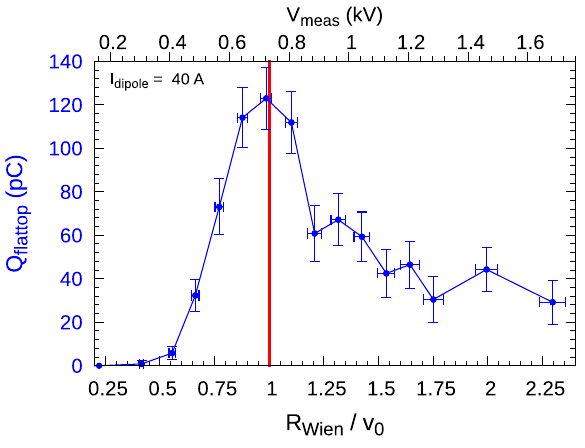
14. Measured charge in the pulse flat top Q ¼ I max · t as a function of the Wien ratio R flattop flattop BCT which is normalized to the velocity v 0 of the 14 keV He þ beam. The Wien ratio is varied by increasing the HV pulse amplitude V while keeping the magnetic deflection field meas